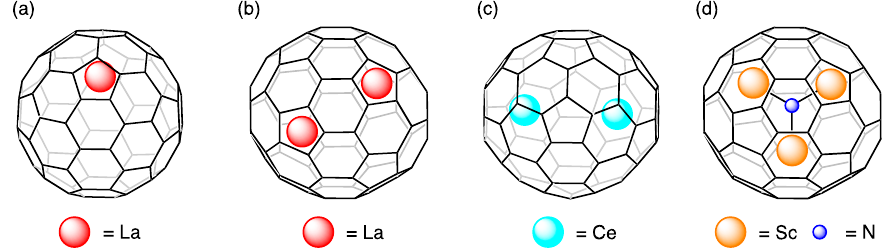
Figure 1. Structures of ( a ) La@ C 2v -C 82 ; ( b ) La 2 @ I h -C 80 ; ( c ) Ce 2 @ D 3 h -C 78 ; and ( d ) Sc 3 N@ I h -C 80 .